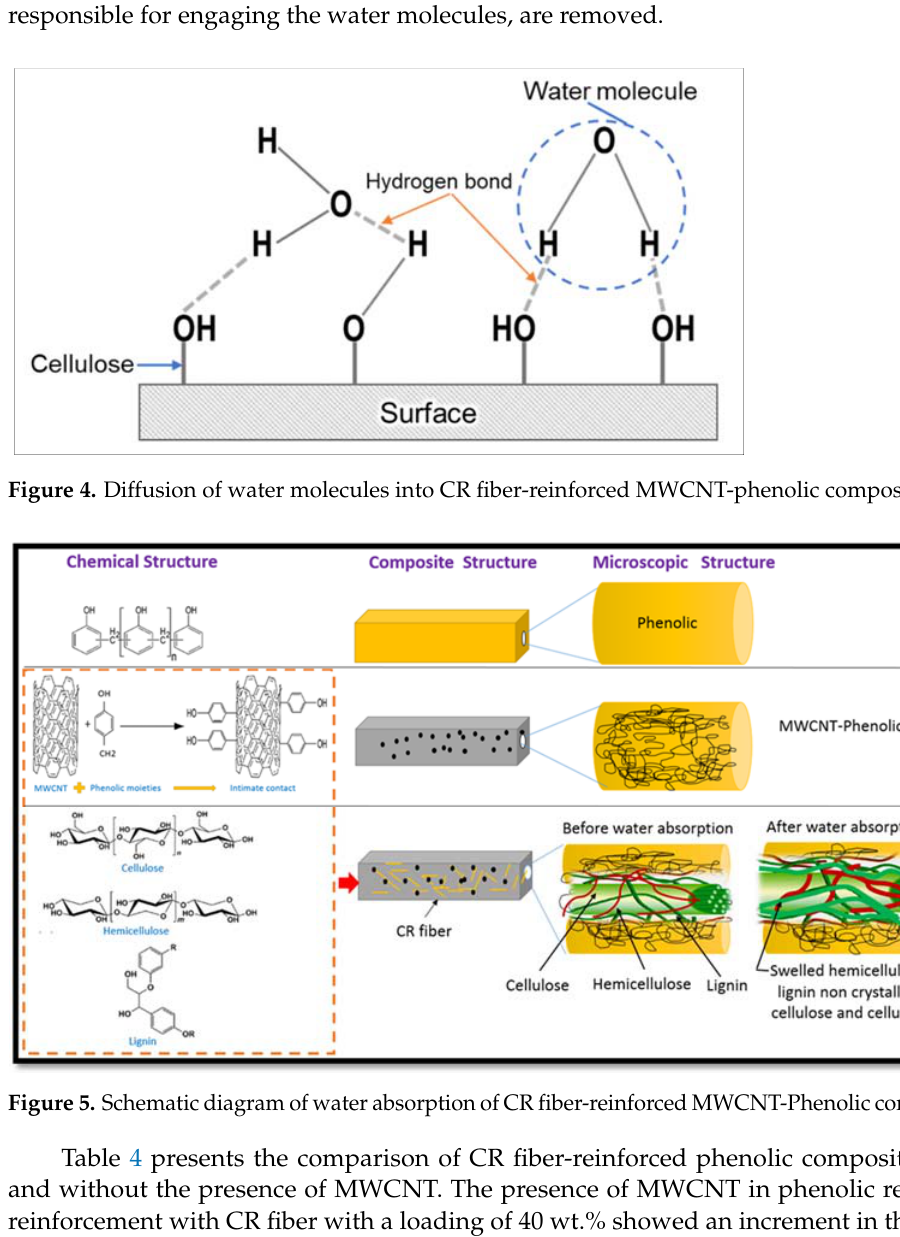
Figure 4. Water molecules penetrate by capillary forces between the fibers and interfere